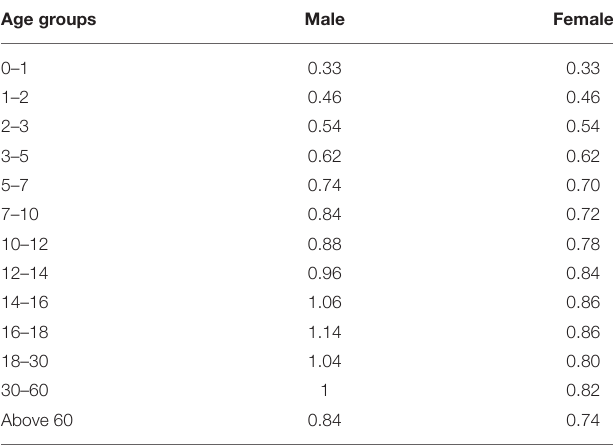
TABLE 2 | The adjusted age of the members of the household a . TABLE 3 | The definition of all factors in the final logistic regression